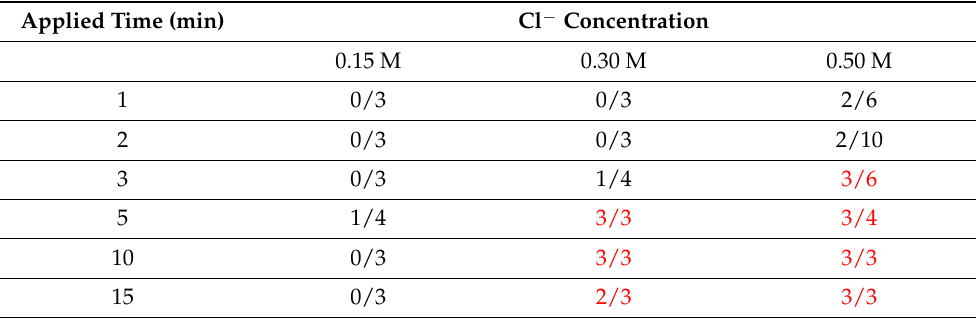
Figure 2. Electrochemical gluing via HClO: ( A ) Schematic. ( B ) Photograph of electrochemically glued hydrogel fibers. The fibers were floated in PBS, and the Cl − concentration was adjusted to 0.30 M. Then, a voltage of 0.95 V vs. Ag/AgCl was applied to the intersection of the fibers for 300 s. ( C ) Time-course images of electrochemically glued IPC fibers in normal PBS for 7 days. Voltage application time: 900 s; Cl − concentration: 0.50 M. The contrast and the brightness of the images were adjusted to improve fiber visibility. Table 1. Success rate (number of successes/number of trials) of the electrochemical glue under various conditions. Red figures indicate that the success rate was over 50%.